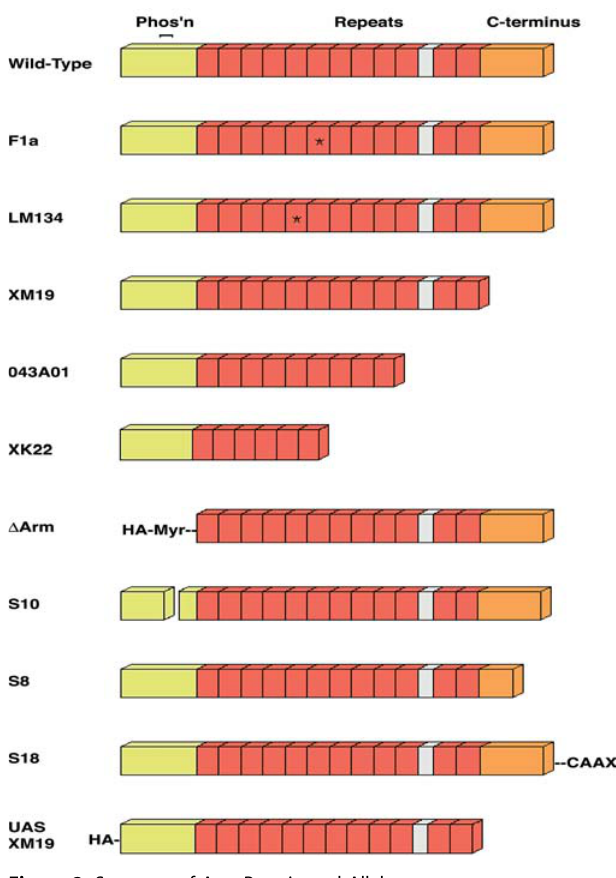
Figure 3. C-Terminally Truncated Arm Can Signal If Its Levels Are Increased (A) arm XM19 shows a wg mutant phenotype. (B) Expression of GAL4/UAS-driven Arm XM19 protein in arm XM19 mutant background rescues this to a wild-type pattern. (C) The same is true of expression of an endogenous promoter-driven truncation Arm S8 . (D) Removal of Zw3 has no effect on arm XM19 cuticle pattern. (E) However, when Arm S8 is introduced into arm XM19 , zw3 mutants, the cuticle is naked. (F) Wild-type embryo is shown for comparison. (G–I) Arm stainings reveal that expression of UAS–Arm XM19 (stained for the HA tag [G]) and Arm S8 (stained for Arm [H]) is present in stripes corresponding to Wg striping, whereas removal of Zw3, along with Arm S8 expression, leads to uniform and high levels of Arm throughout the epidermis